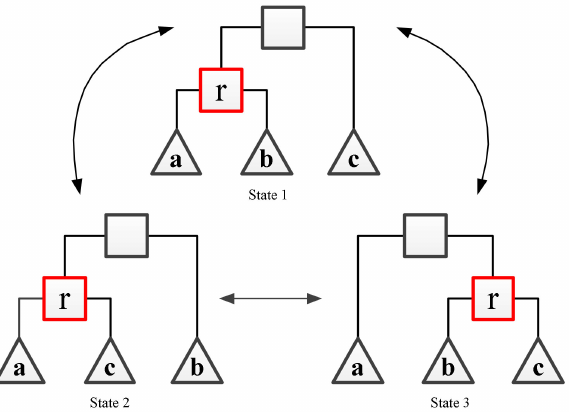
Figure 6. The β transformation of the inner edge of type.